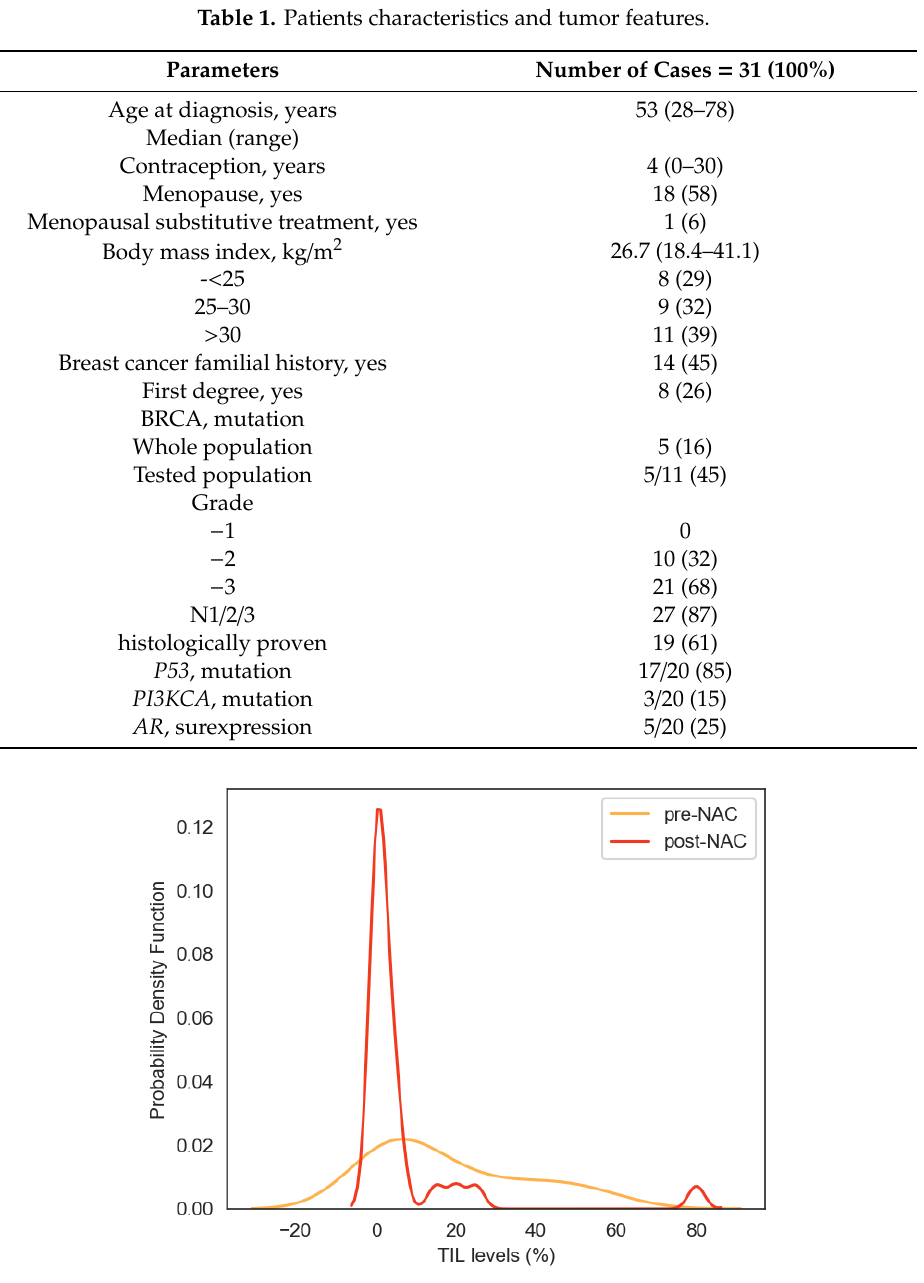
Figure1. Distributionofpre-andpost-neoadjuvantchemotherapy(NAC)tumor-infiltratinglymphocyte Figure 1. Distribution of pre- and post- neoadjuvant chemotherapy ( NAC) tumor-infiltrating (TIL) levels (kernel density lymphocyte ( TIL) levels (kernel density plot).